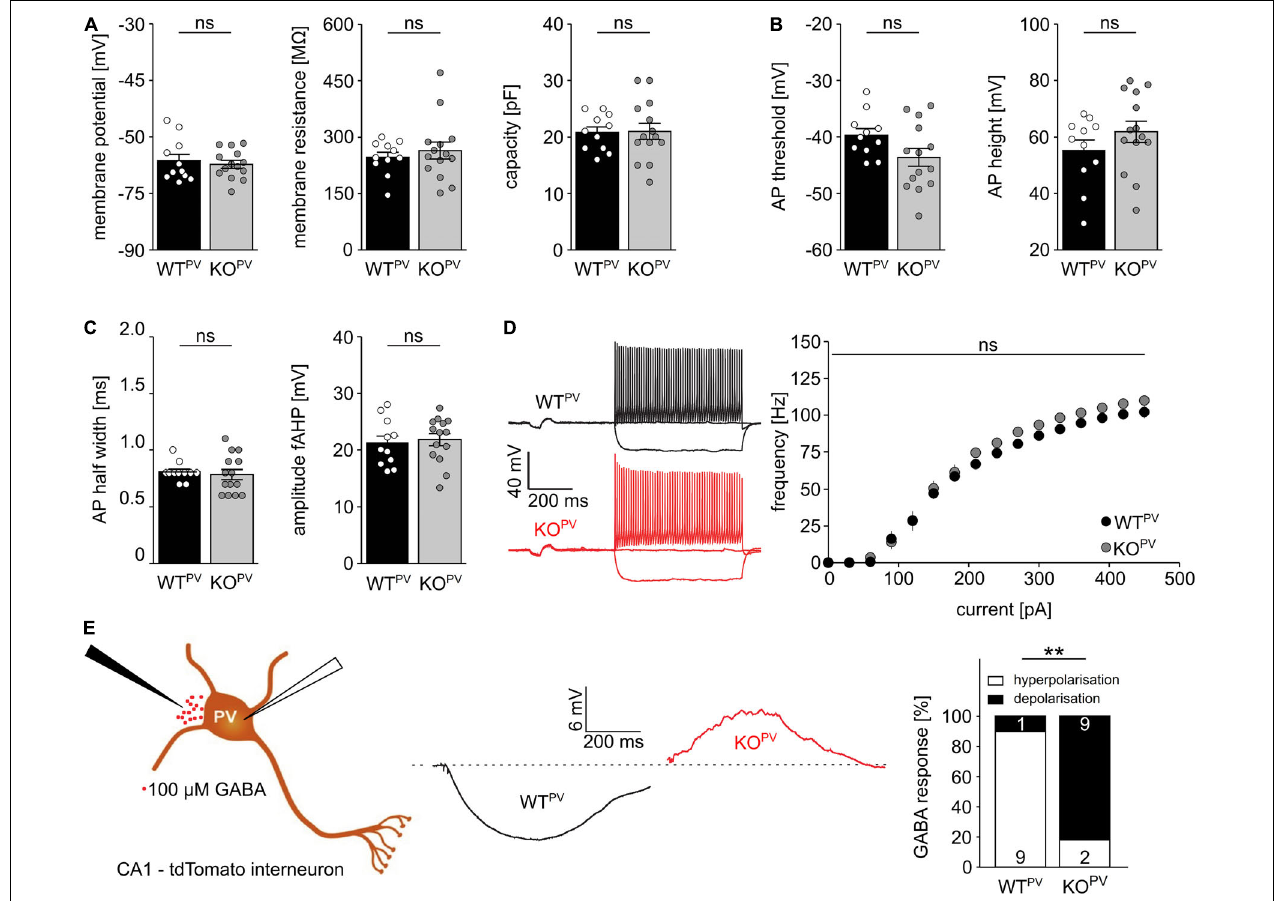
FIGURE 3 | Disruption of KCC2 does not change the intrinsic excitability of PV-INs but changes the polarity of their GABA response. (A) Intrinsic properties such as resting membrane potential, membrane resistance and capacity are not altered in the absence of KCC2 ( n = 11/14 cells from N = 5/6 mice; unpaired Student’s t -test; ns not significant). (B) Action potential (AP) threshold and amplitude are as well unchanged in the absence of KCC2 ( n = 11/14 cells from N = 5/6 mice; unpaired Student’s t -test; ns not significant). (C) Action potential half width (left) and fast after-hyperpolarization (fAHP) (right) of PV-INs is similar in WT PV and KO PV ( n = 11/14 cells from N = 5/6 mice; unpaired Student’s t -test; ns not significant). (D) The spike frequency upon current injection is not altered by disruption of KCC2 ( n = 11/14 cells from N = 5/6 mice; 2-way ANOVA; Bonferroni post-test; ns not significant). (E) 100 mM GABA puffs were applied to tight seal ( > 4 G (cid:127) ) patched tdTomato-labeled interneurons in the CA1 region of acute brain sections of 8-week-old WT PV and KCC2 KO PV mice ( n = 10/11 cells from N = 5/6 mice; Fisher’s exact test; ** p = 0.0019).